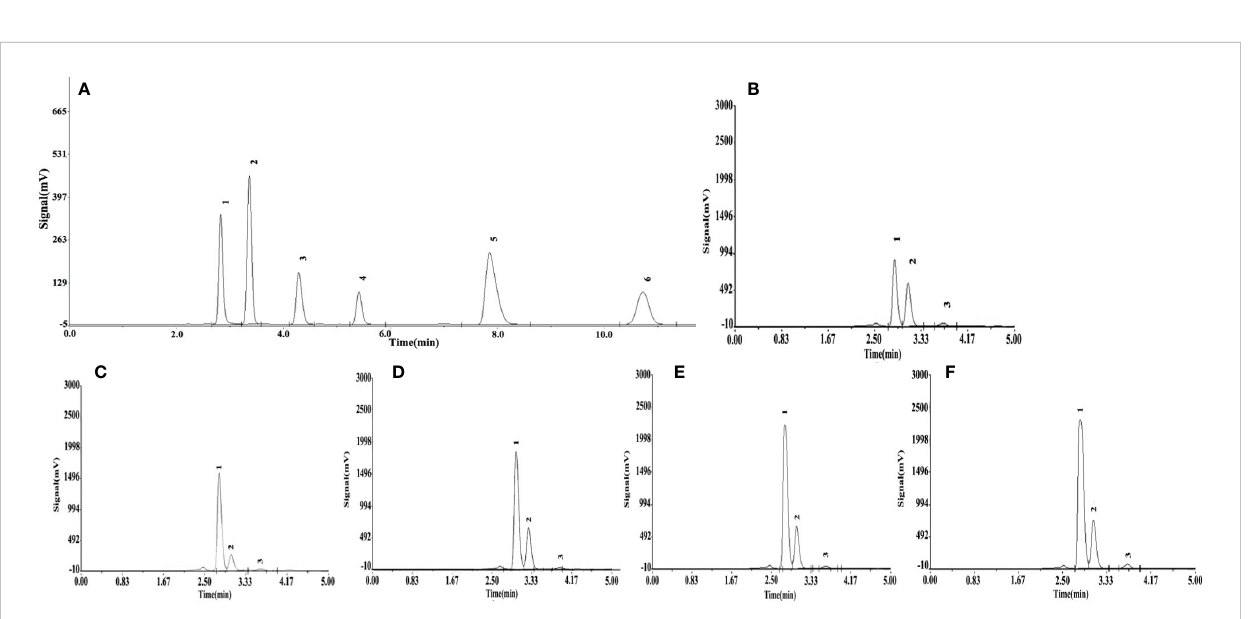
FIGURE 7 Effects of different Si treatments on organic acids content in root exudates of S. alfredii . Organic acid standard solutions (A) , root exudates of S. alfredii under different Si treatments (B~F). (B) : control treatment, (C, D, E, F) were the Si concentrations of 0.5, 1.0, 1.5 and 2.0 mmol ∙ L -1 , respectively.